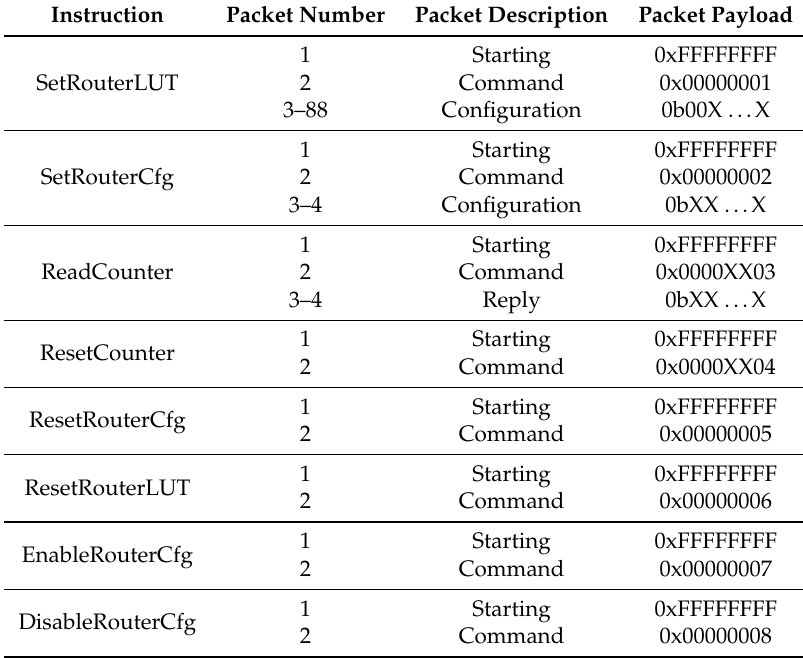
Table 1. Configuration packet sequences used to configure the router logic and to collect statistics. These packet sequences are generated as a response to the execution of configuration